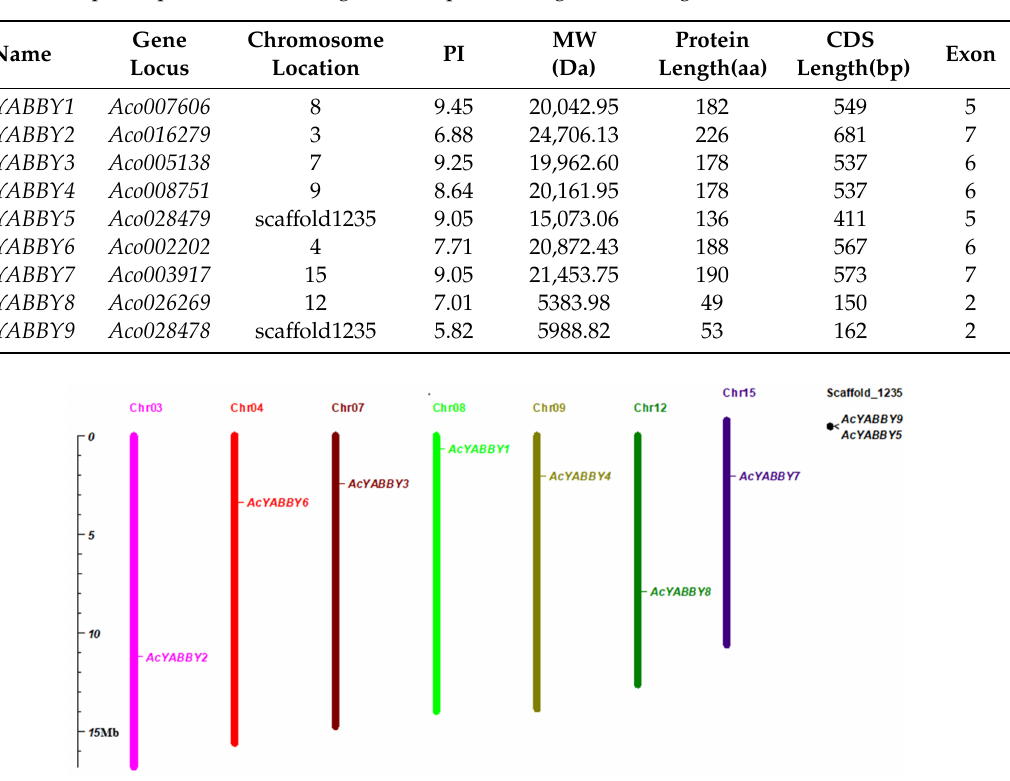
Figure 1. Distribution of YABBY genes in pineapple genome. Pineapple chromosomes and sca ff olds having YABBY genes are shown here. The length of bar represents the size of the